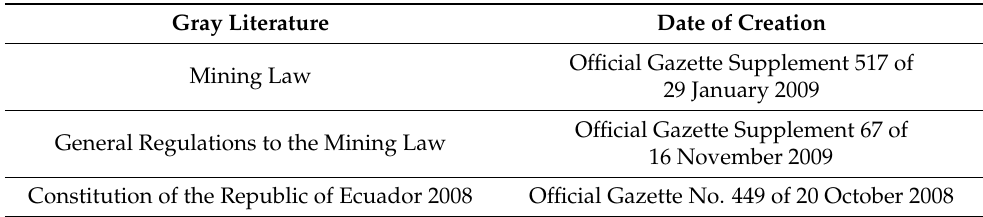
Table 3. Gray literature for the historical status of gold mining. Gray